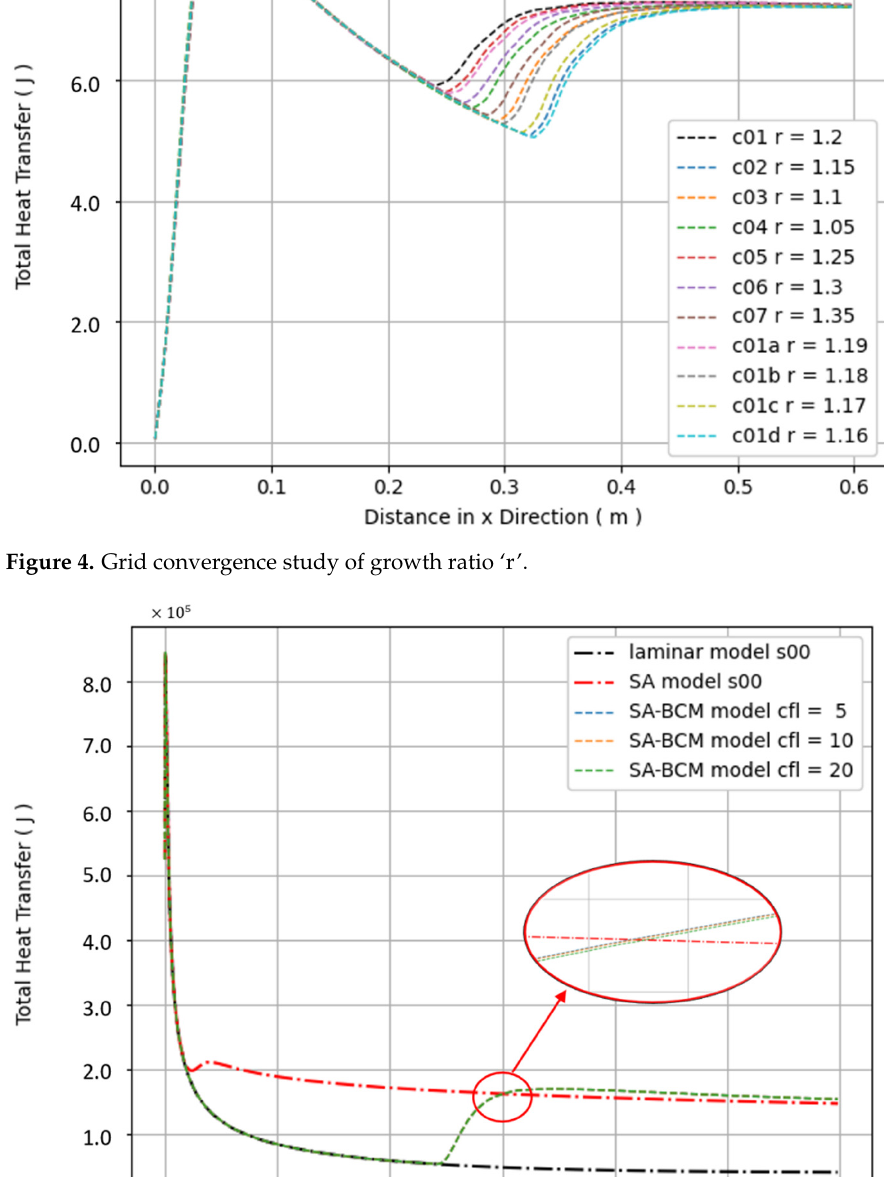
Figure 4. Grid convergence study of growth ratio ‘r’.